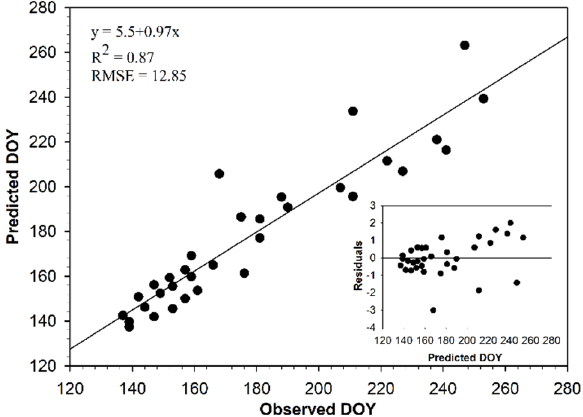
Figure 4. Relationship between observed DOY and simulated DOY in three years. The black line is the regression line between the observed DOY and the simulated DOY. The small panel shows the distribution of the residuals.